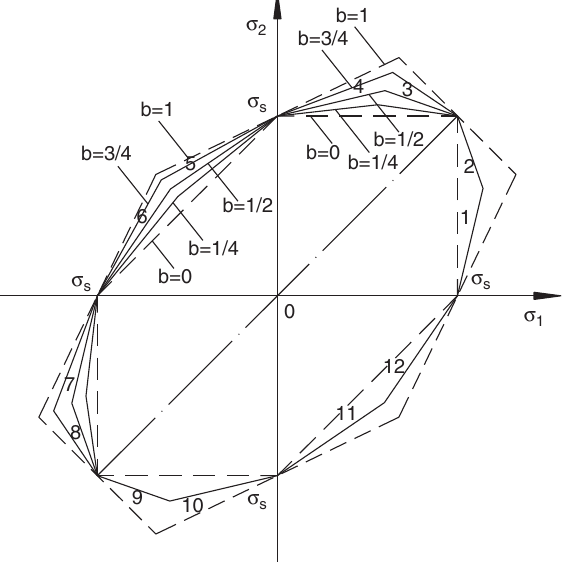
Fig. 5. Yield criterion in plane